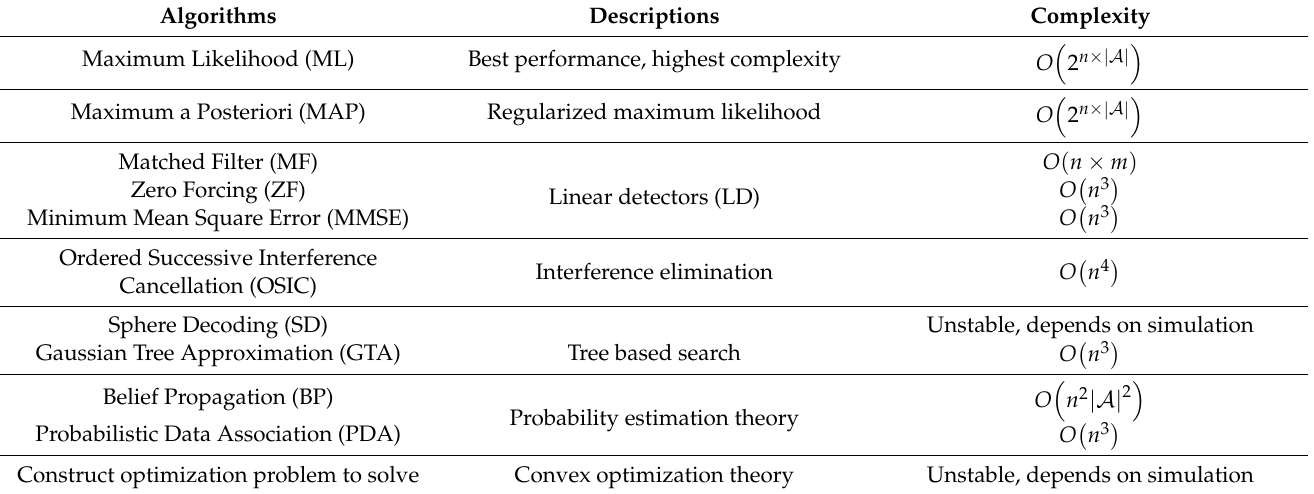
Table 1. Summary of common MIMO detection